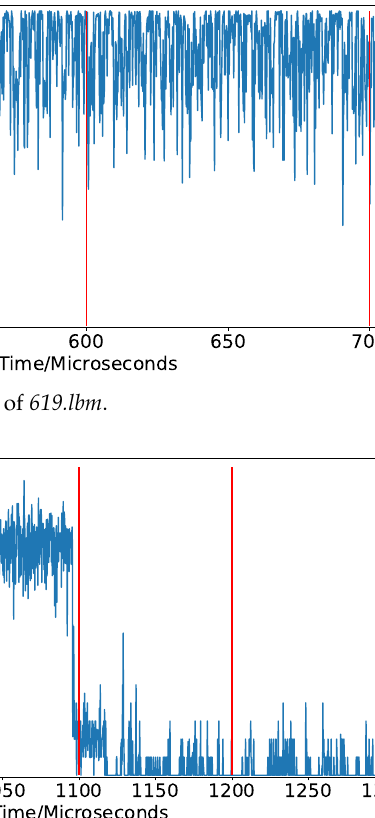
Figure 3. A running fragment of 605.mcf